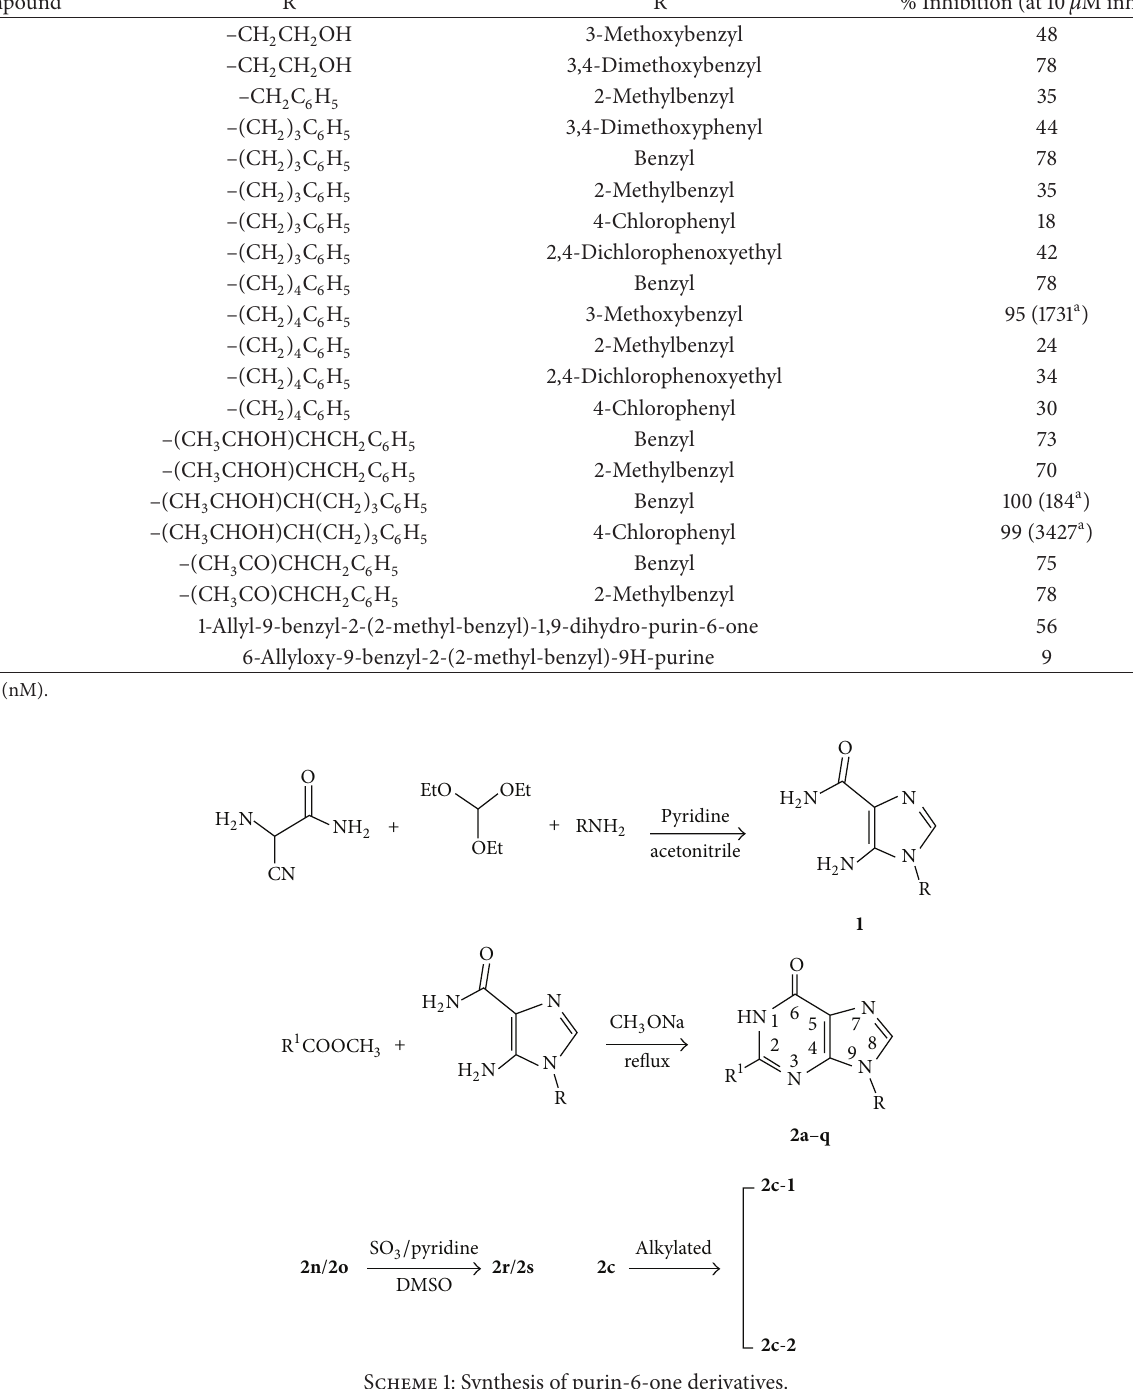
Scheme 1: Synthesis of purin-6-one